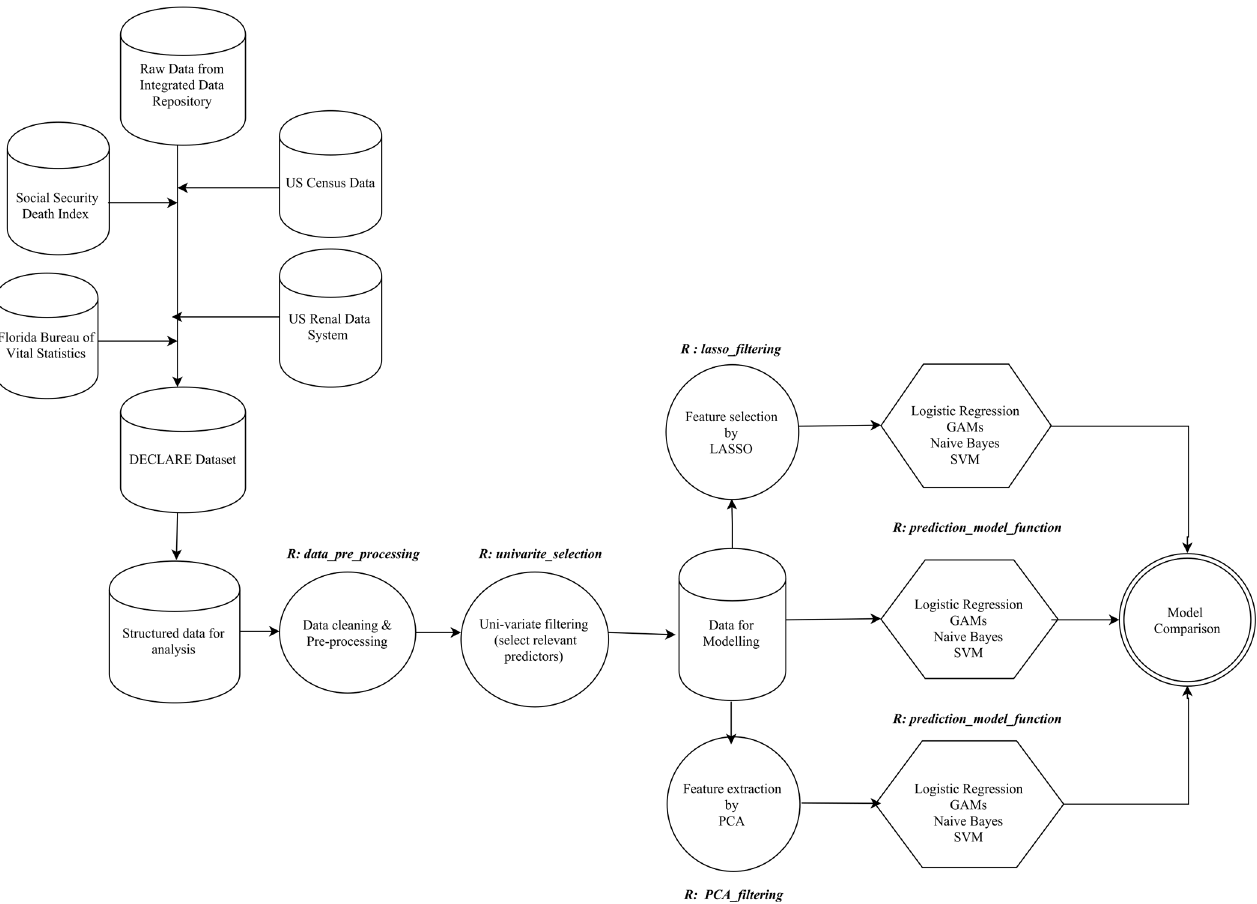
Fig 1. Development flow from raw data to model building. Sequence of steps from aggregation of raw data, data preparation and leading to model building. The R functions used at each stage is represented in bold italics. R functions are available in github repository: https://github.com/ PRISMUF/ML_Algorithm_Postoperative.git. GAM, generalized additive model; SVM, support vector machine; LASSO; least absolute shrinkage and selection operator; PCA, principal component